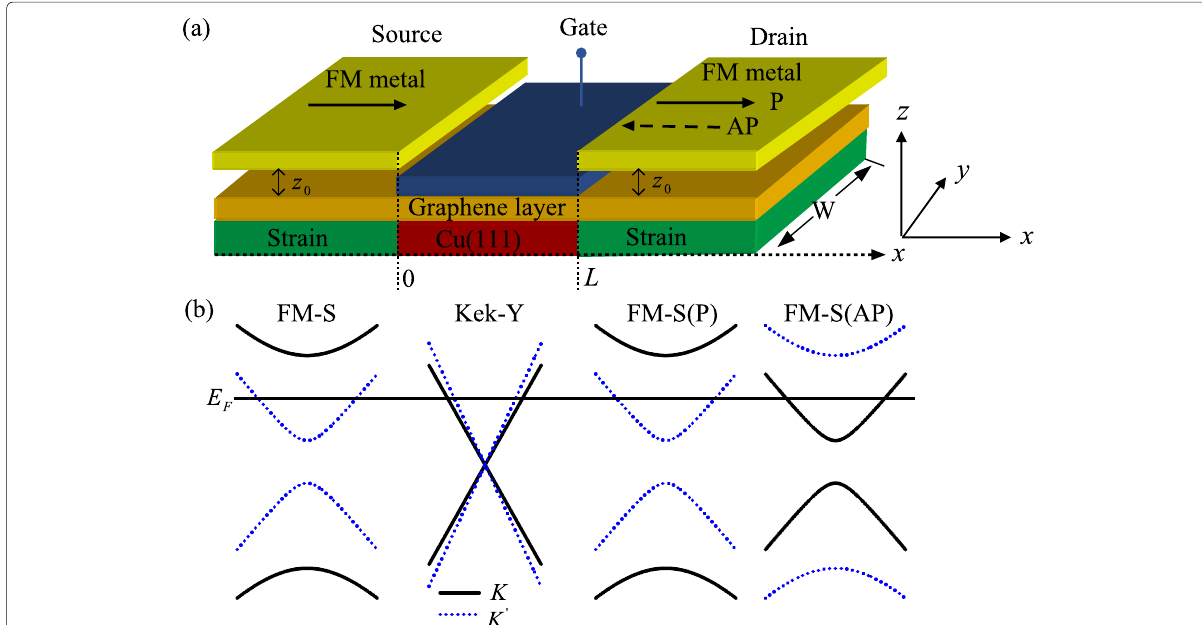
Fig. 1 a Schematic illustration of the VFET utilizing a graphene channel with Kek-Y lattice distortion and a gate bias, which controls the valley orientation of channel electrons. The source and drain are FM-S graphene, which inject and detect electrons in a specific polarization. Where z 0 is the distance between the graphene layer and the FM stripe. L is the channel length, W is the width of the graphene sample in the y direction, and W (cid:3) L . b Band structure near Dirac points. The horizontal line denotes the Fermi energy (color